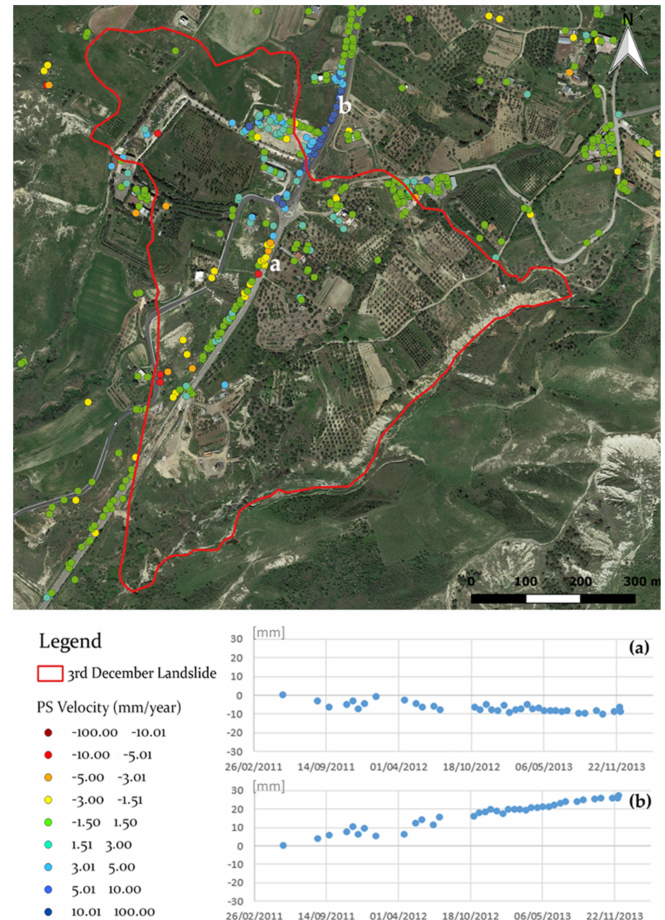
Figure 4. A-DInSAR pre-failure analysis for Montescaglioso landslide (from [39]). (Lat: 40.543928 ◦ ; Lon: 16.652877 ◦ ; WGS84) including the average velocity map and the time series of displacement of two representative measurement points in sectors ( a ) and ( b ).